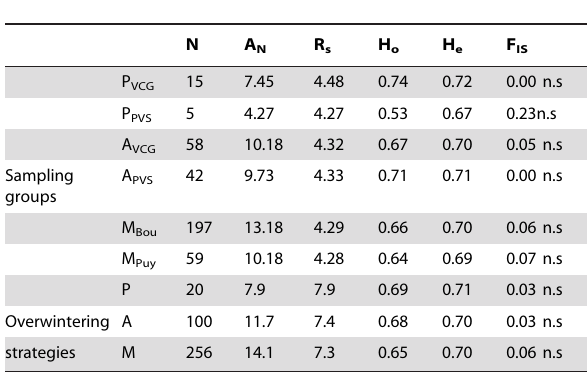
Number of individuals sampled (N), mean number of allele per locus per sampling group or overwintering strategy (A N ), mean allelic richness corrected for sample size of 5 individuals for sampling groups and 20 individuals for overwintering strategies (R S ), expected heterozygosity under HW conditions (H e ), observed heterozygosity (H o ), inbreeding coefficient (F IS ) and its statistical significance (*P , 0,05; n.s